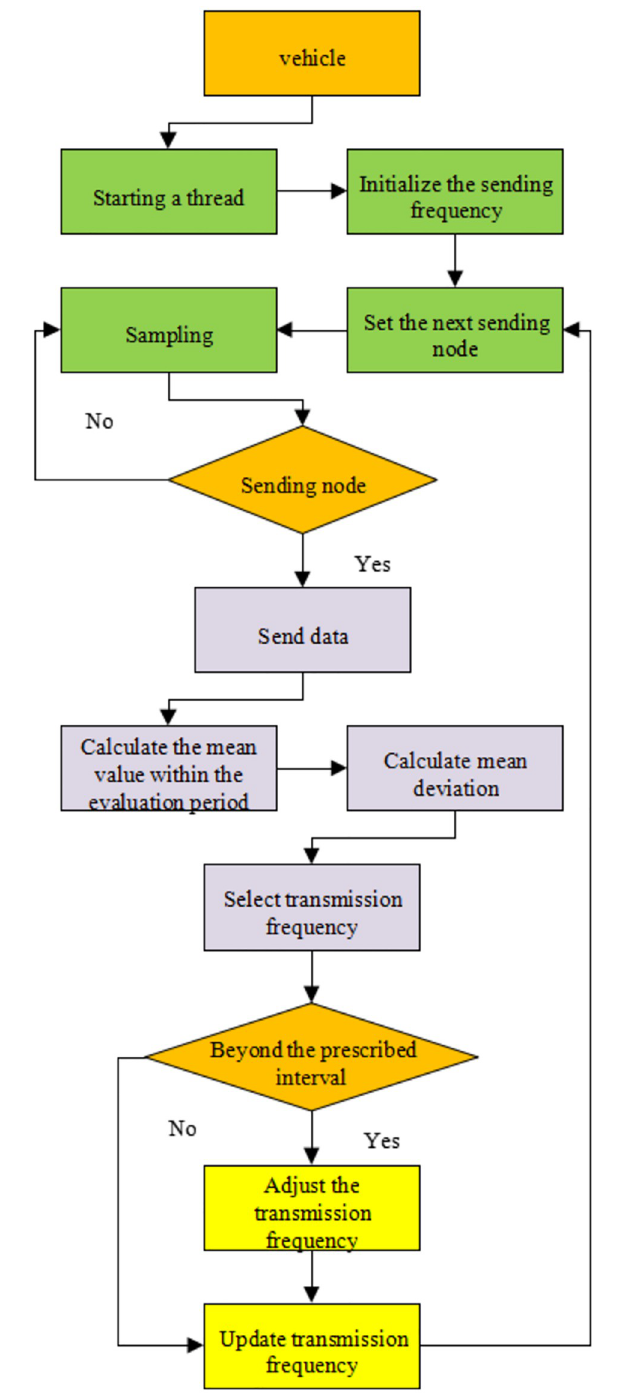
Fig 5. Procedures of the greedy